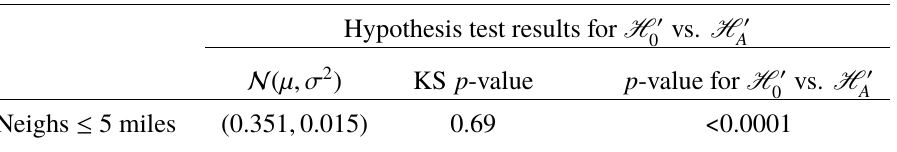
Figure 3. Results for KS-test of the distribution of (second column) β N − 2SE and (third column) H (cid:48) vs. H (cid:48) A